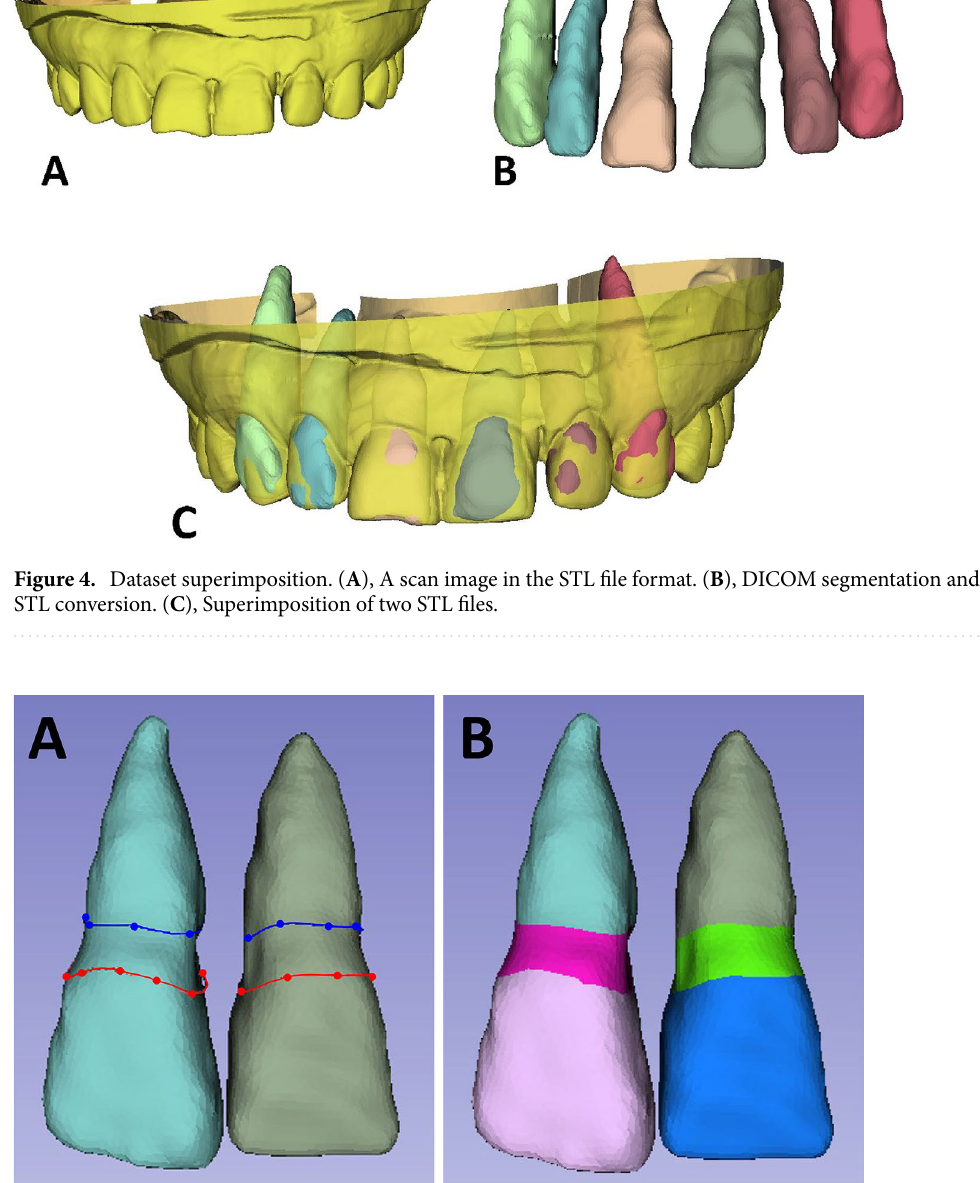
Figure 5. Polygonal annotation of the dataset. ( A ), Detection of the annotated lines. ( B ), Annotation of crown and emergence profile